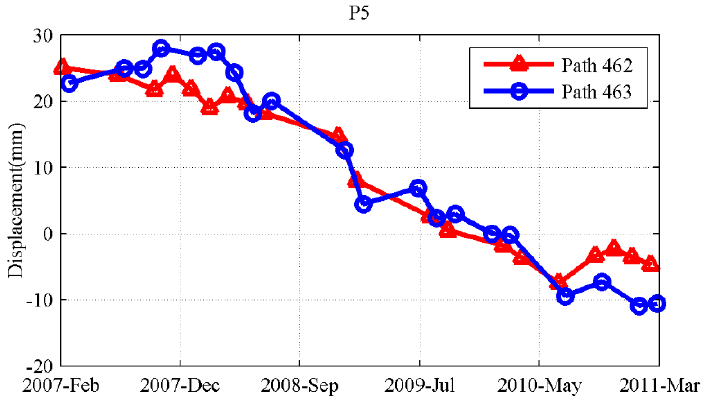
Figure 8. The distribution of displacement rate difference for the overlapping areas between ( a ) path 464 and path 463 datasets; ( b ) path 463 and path 462 datasets.